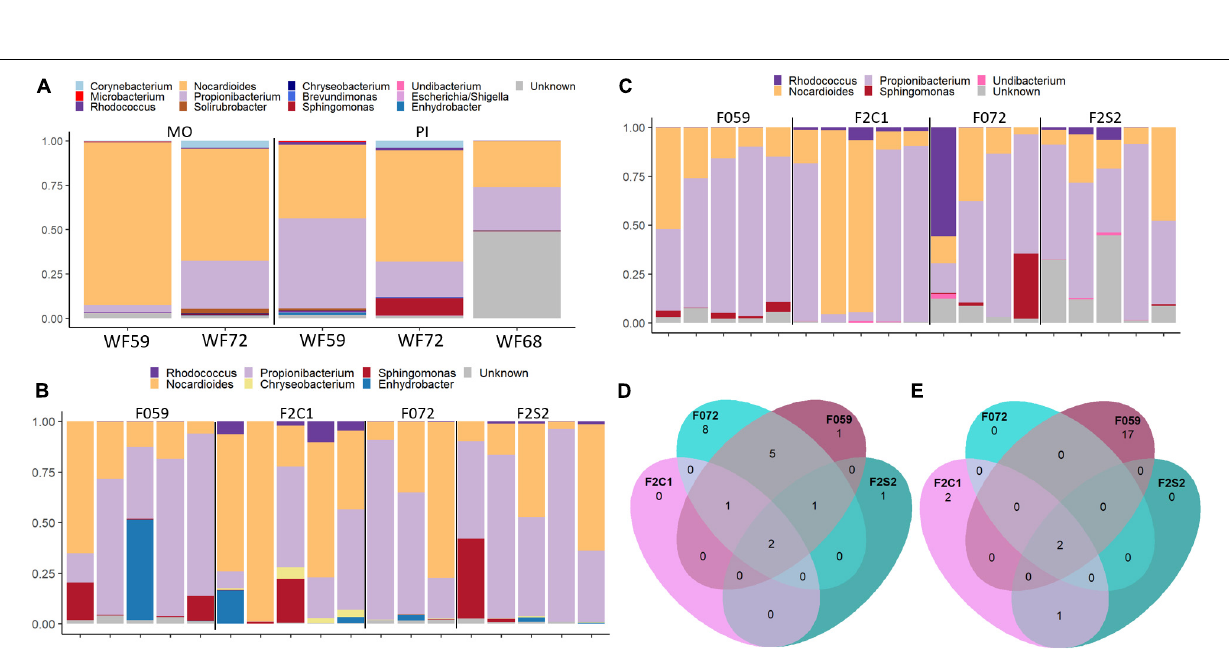
FIGURE 6 | Core and shared microbiome in the mucus from the buccal cavity and posterior intestine of Nile tilapia from wild, F0, and F2 generations. (A) Core microbiome in the mouth mucus and posterior intestine of wild Nile tilapia. Core microbiome in the (B) buccal cavity and (C) intestine of F0 and F2 generations. Shared core microbiome in the (D) buccal cavity and (E) intestine of F0 and F2 generations. In panel (D) , five ASVs of Propionibacterium were common in both F059 and F072 and one ASV was common in both F0 and F2 generations. MO, buccal cavity; PI, posterior intestine. F0 generation: F059, F072 and F2 generation: F2C1,